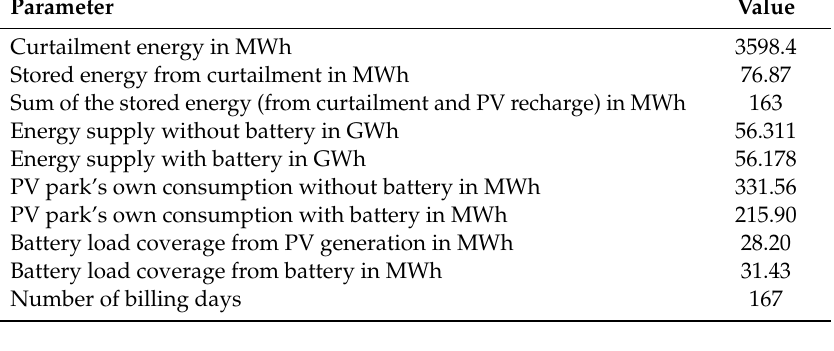
Table 3. Techno-economic parameters for the adopted model.